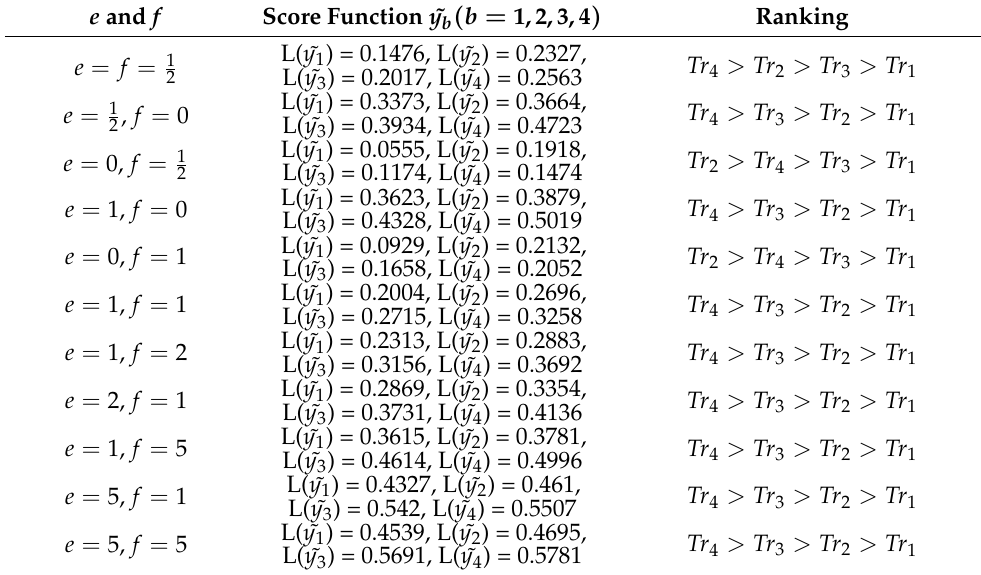
Table 4. Ranking outcome for different values of e and f . e and f Score Function ˜ y b ( b = 1, 2, 3, 4